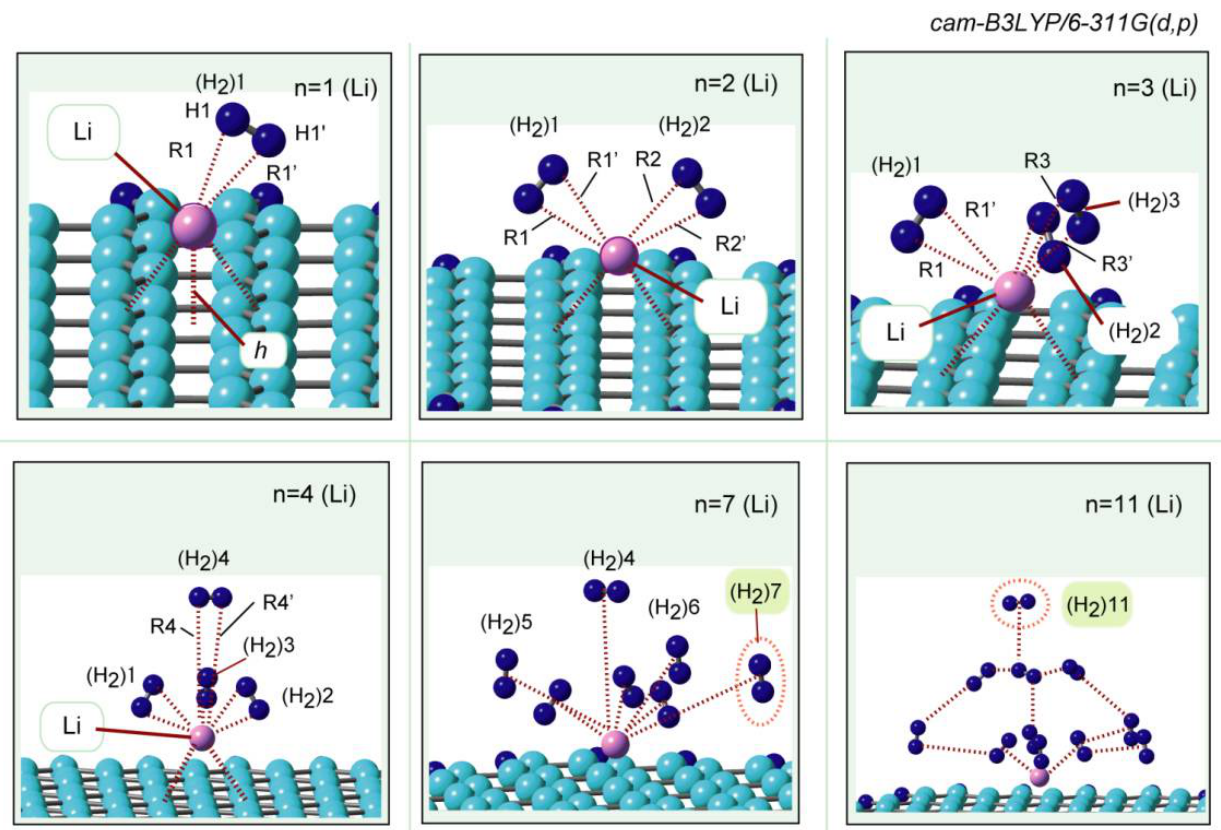
Figure 2. The optimized structures of the GNF(37)–Li(atom)–(H 2 ) n ( n = 1, 2, 3, 4, 7, and 11). The calculations were performed at the CAM-B3LYP/6-311G(d,p) level. Reprinted with permission from [38]. Copyright 2019 American Chemical Society.